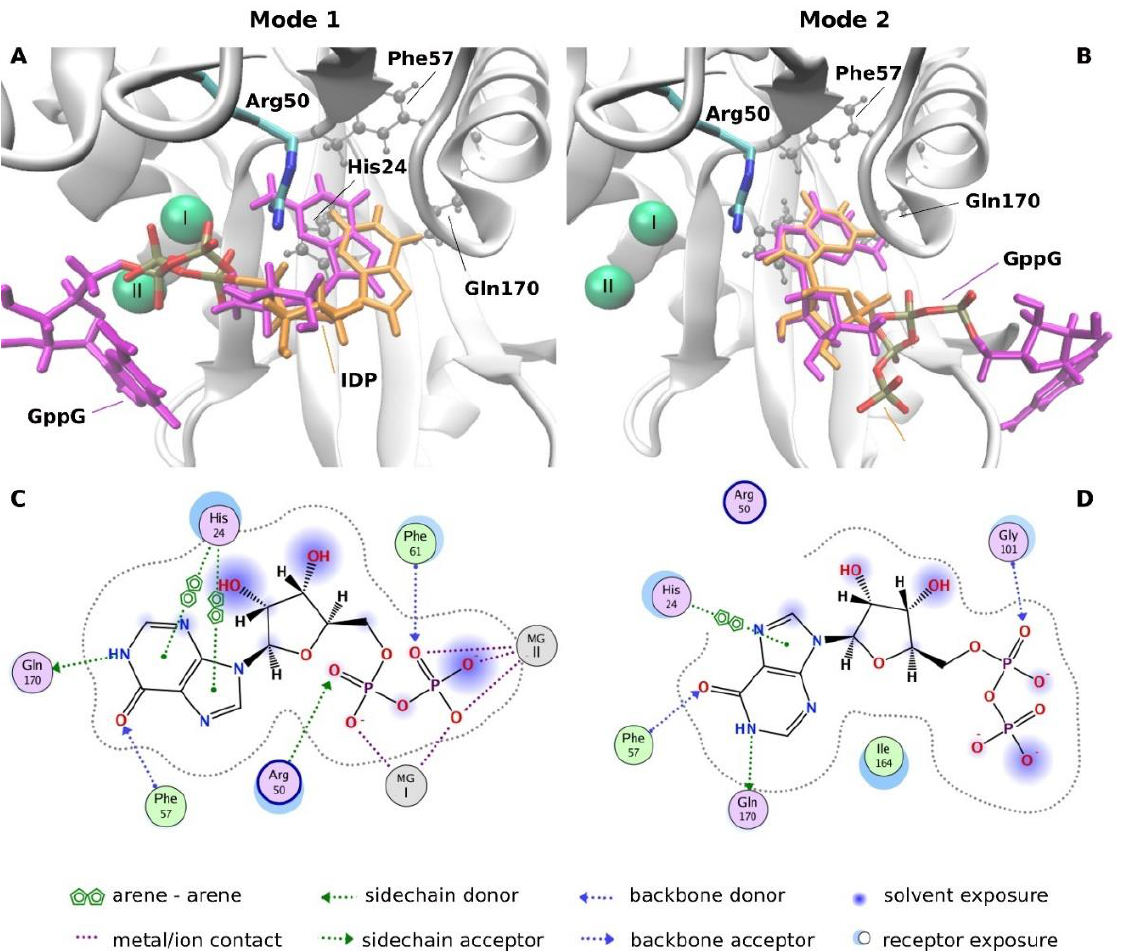
Figure 6. Top: IDP and GppG bound to hNudt16 in docking ( A ) mode 1 and ( B ) mode 2. Bottom: Schematic illustration of IDP interactions in ( C ) mode 1 and ( D ) mode 2.